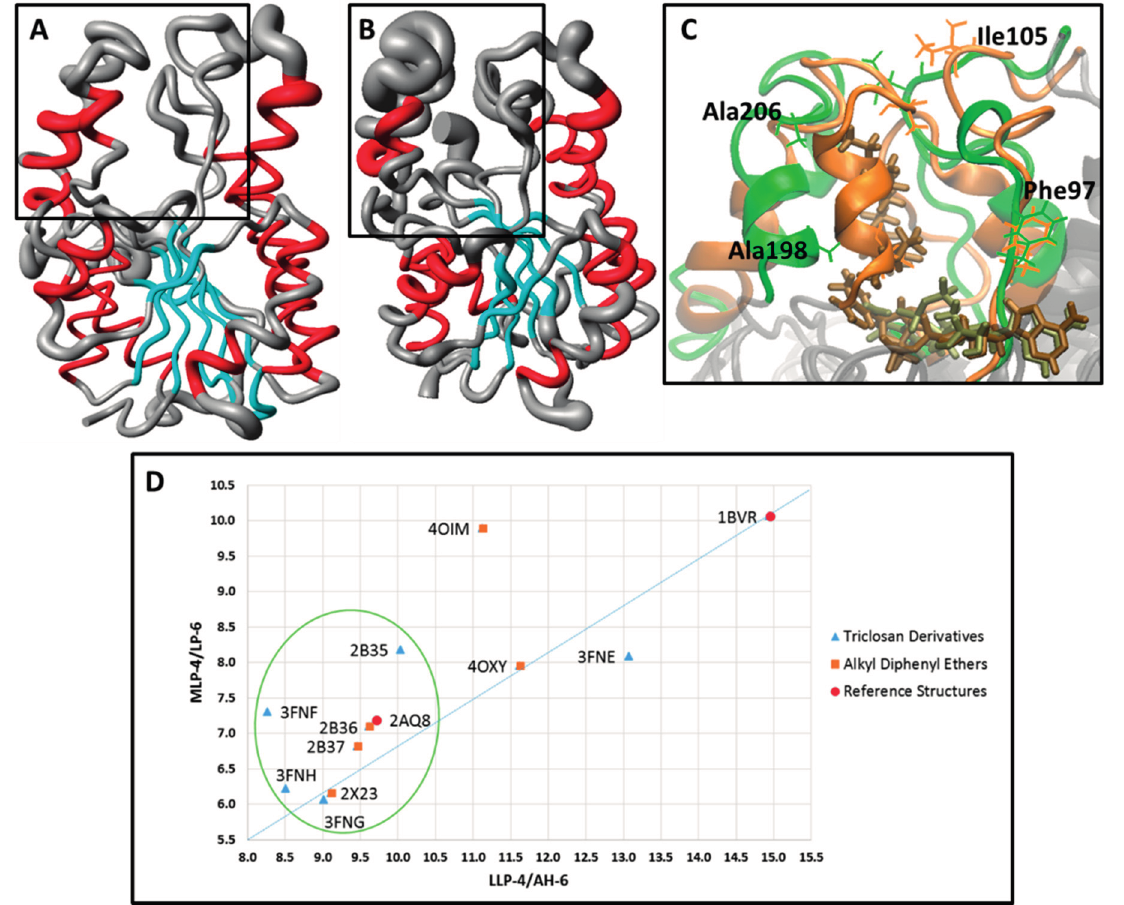
Figure 4. Spatial RMSD (RMSF) of ( A ) InhA-NADH (2AQ8) and ( B ) InhA-NADH-THT (1BVR) (protein secondary structure color code: α -helix, red; β -sheet, cyan; loop, grey) during the MD simulations. ( C ) Close view of the substrate binding pocket overlap between InhA-NADH (orange) and InhA-NADH-THT (green), showing the Phe97 (LLP-4), Ala198 (AH-6), Ile105 (MLP-4), and Ala206 (LP-6) residues used for measure the LLP-4/AH-6 and MLP-4/LP-6 distances to characterize the protein open and closed states. ( D ) Graphic of the MLP-4/LP-6 versus LLP-4/AH-6 distances. The points within the circle represent complexes where the enzyme adopts a closed conformation as in